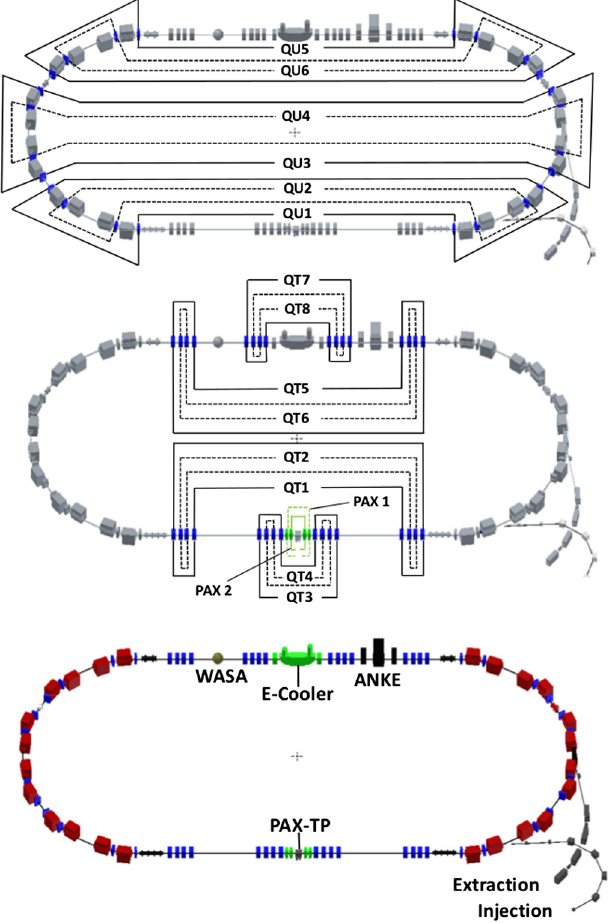
FIG. 1. Bottom panel: Floor plan of the COSY facility. The 24 dipole magnets are shown in red, the quadrupole magnets in blue except those around the PAX target point (PAX-TP) and the 100 keVelectron cooler which are shown in green. The quadrupole magnets of COSY are combined into quadrupole families, each consisting of four magnets with a common current supply. There are eight families for the telescopic straight sections (QT1 to QT8, middle panel) and six for the arcs (QU1 to QU6, top panel). The PAX quadrupoles of the low- β insertion at the PAX-TP are combined into an outer pair (PAX1) and an inner pair